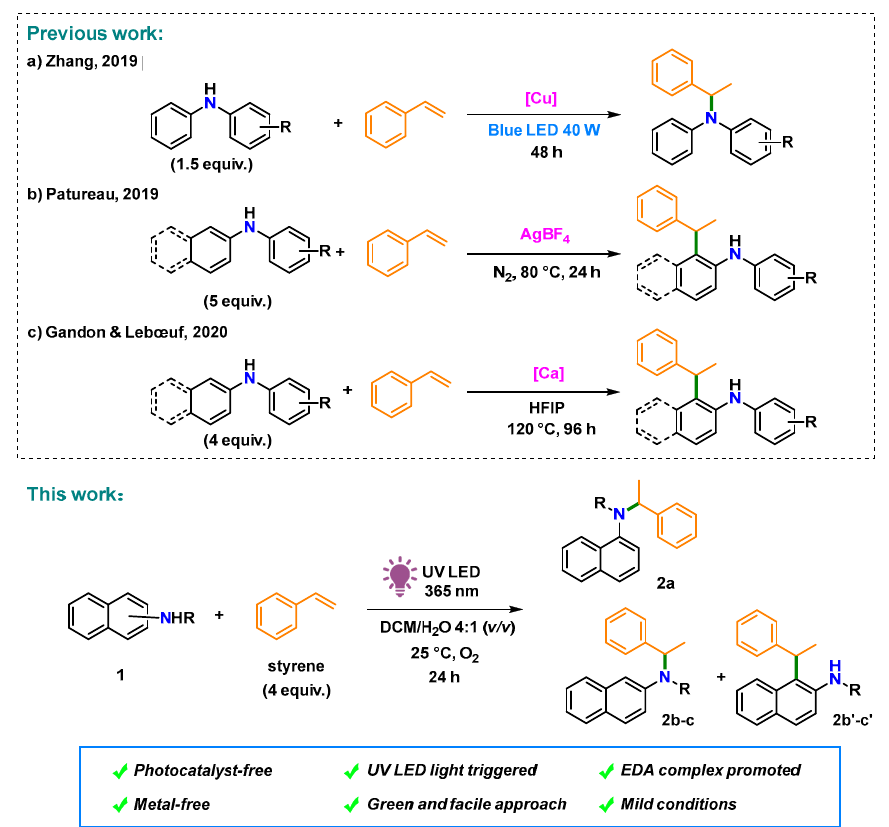
Figure 1. Photoinduced metal- and photocatalyst-free aerobic C–N bond formation of styrene and naphthylamine derivatives. (a) Zhang, (2019) [30]; (b) Patureau, 2019 [31]; (c) Gandon & Lebœuf, 2020 [32].